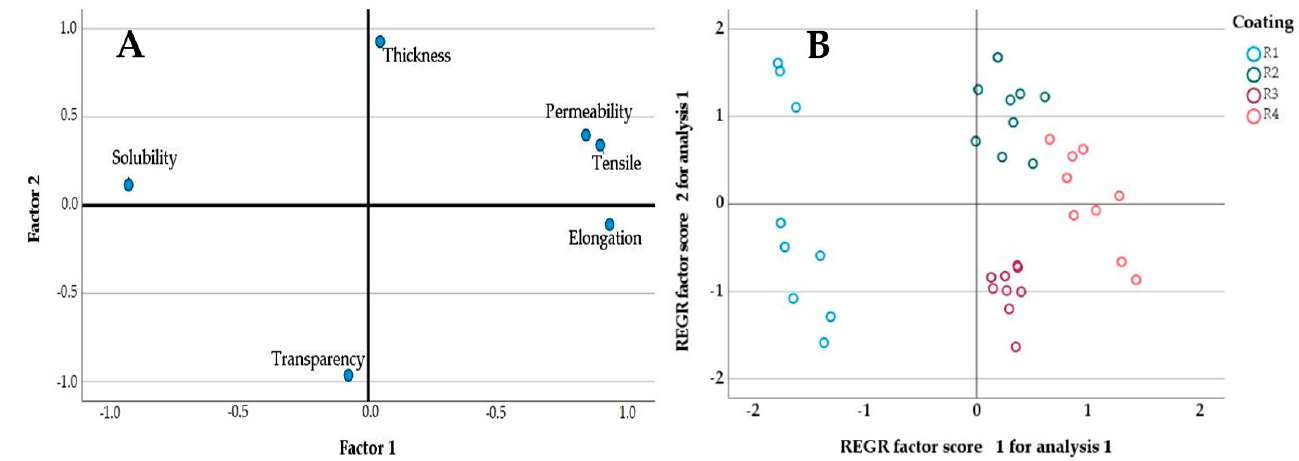
Figure 1. Factor analysis results. ( A ) Component plot in rotated space ( B ) Scatter plot of points.